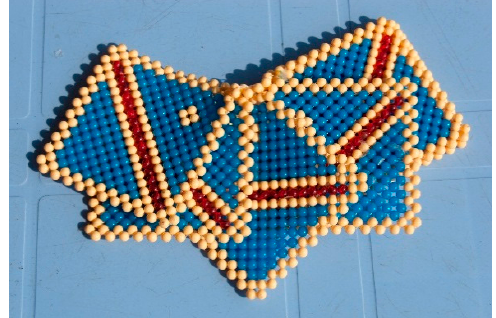
Figure 2. Coasters. Figure 2. Coasters.